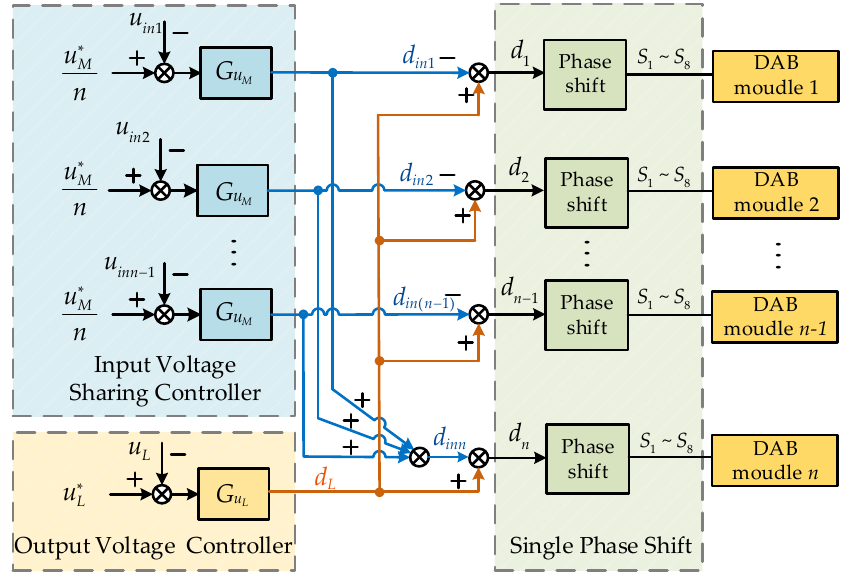
Figure 3. Control block diagram of the ISOP DCT.